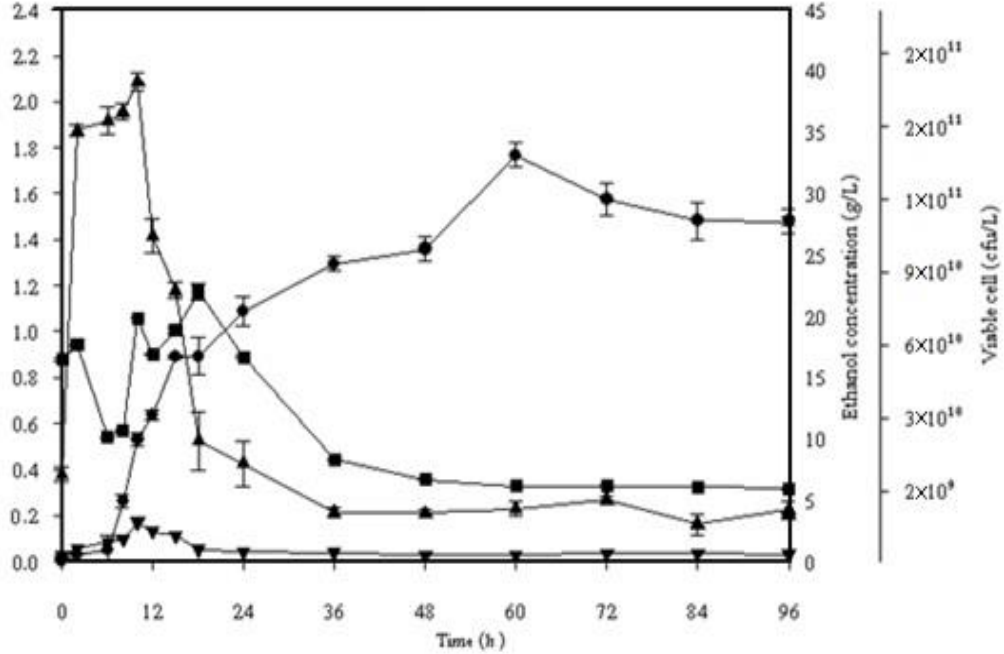
Figure 2. Enzyme hydrolysis of oil palm frond ( A ) before pretreatment (raw material) and ( B ) after pretreatment: (●) glucose concentration and ( ○ ) cellobiose concentration in g/L.